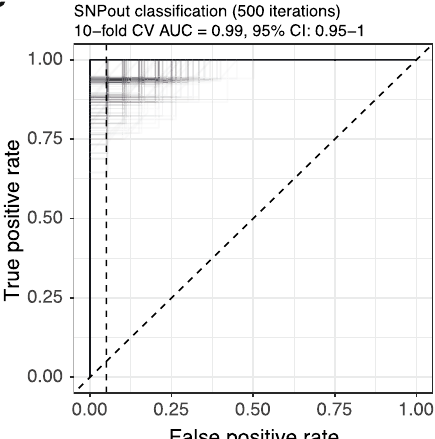
Signature fi ttingwasperformedwithSNPsretained,asbefore,and all signature contributions are shown in Supplementary Data 4. Sig- natures previously identi fi ed in tumors by Alexandrov et al. 12 for each cancer type were used for signature detection with 95% speci fi city. all cancer types tested, none showed a signi fi cant correlation between